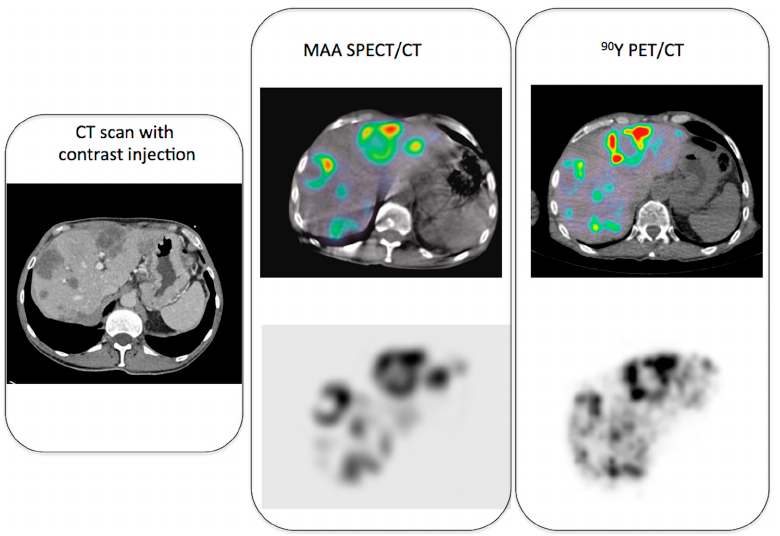
Figure 1. Example of pre-therapy imaging (MAA SPECT/CT) and post-therapy imaging ( 90 Y PET/CT) in a patient with colorectal metastases.